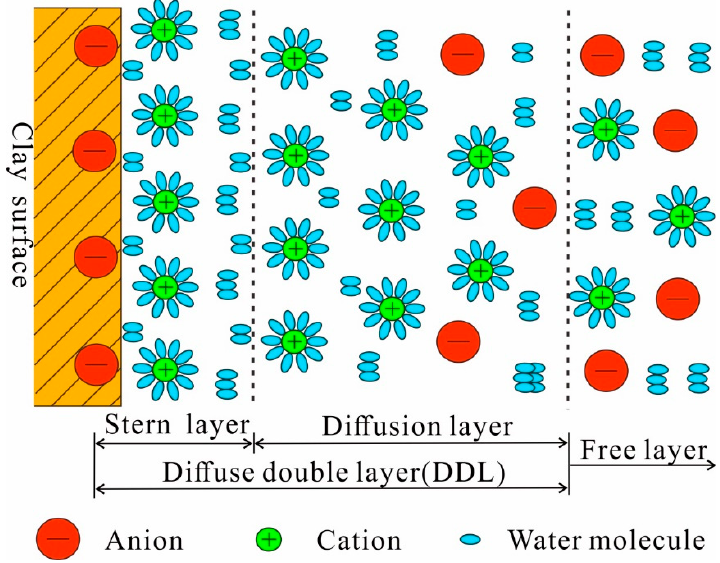
Figure 9. The structure diagram of the diffuse double layer (compiled from [19]).